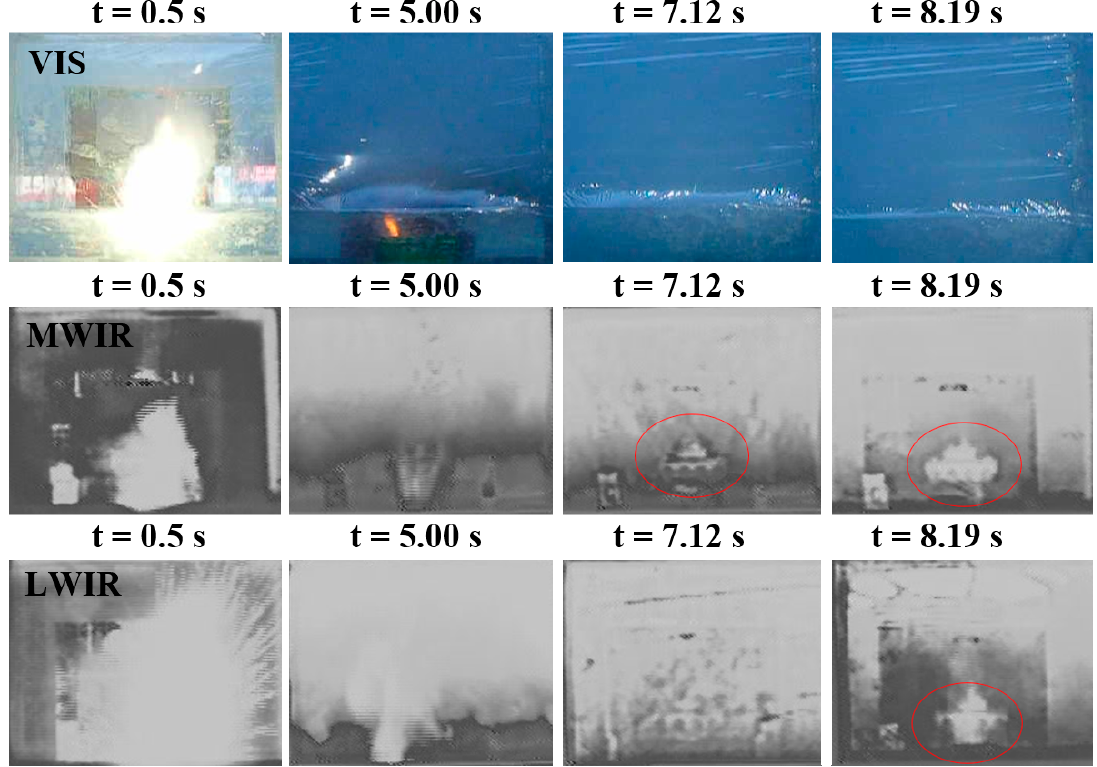
Figure 6. VIS, MWIR and LWIR